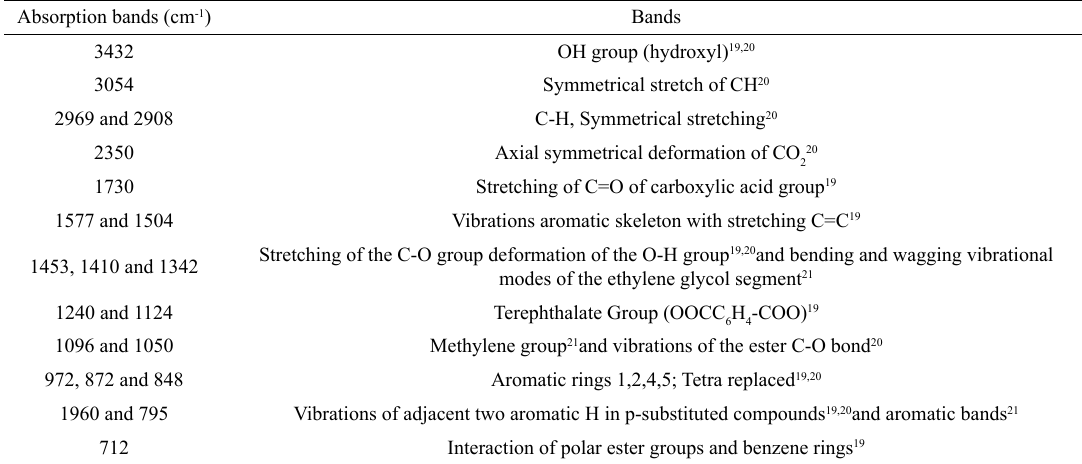
Table 2. Bands with assigned vibrational modes from FTIR specgtrum of the PET sample. Absorption bands (cm -1 )